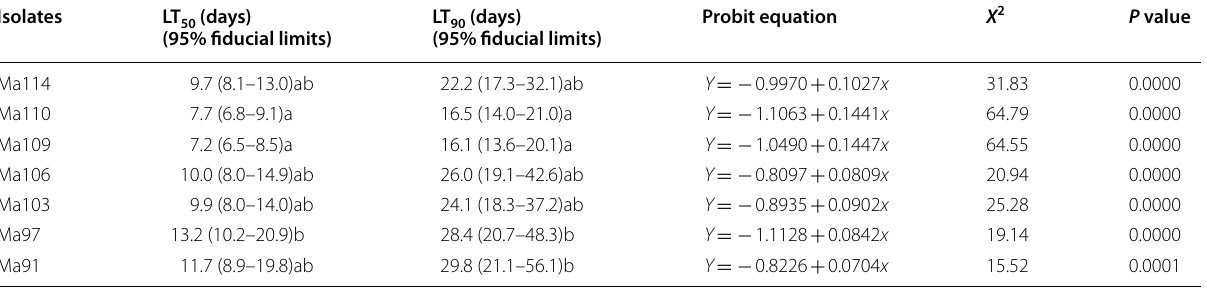
Different letters indicate significant differences according to the overlap of the fiducial limits